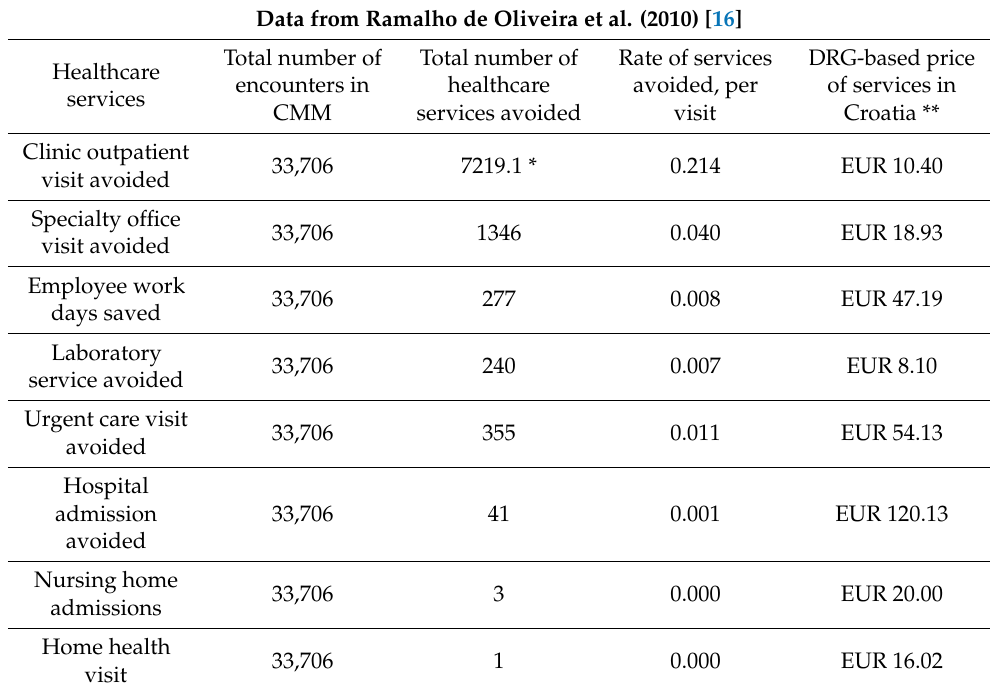
Table 4. Rates of avoided healthcare service utilisation and their respective costs in Croatia. Data from Ramalho de Oliveira et al. (2010)